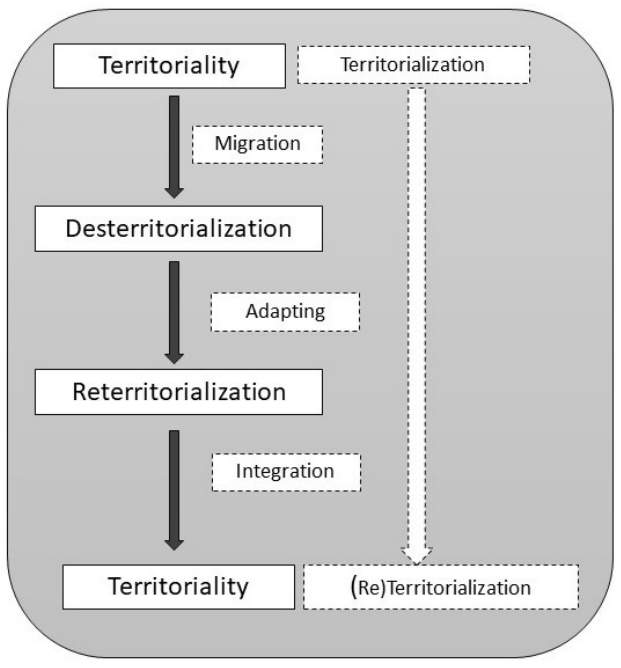
Figure 1. Central concepts of the study.